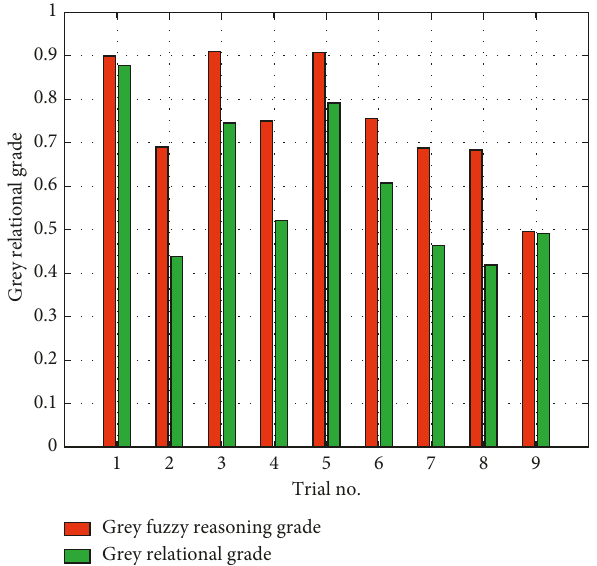
Figure 13: Comparison between obtained GRG and